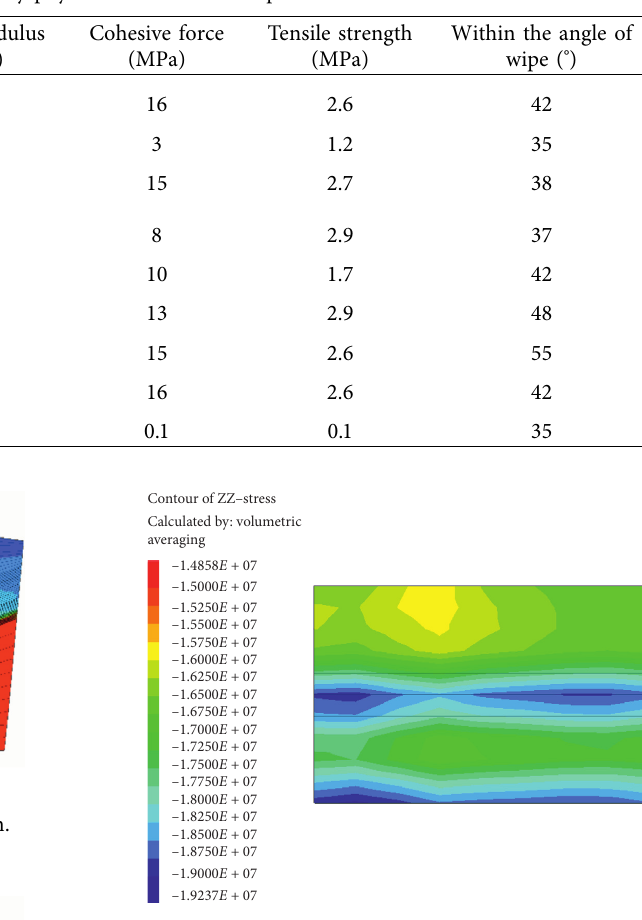
Table 1: Basically physical and mechanical parameters.